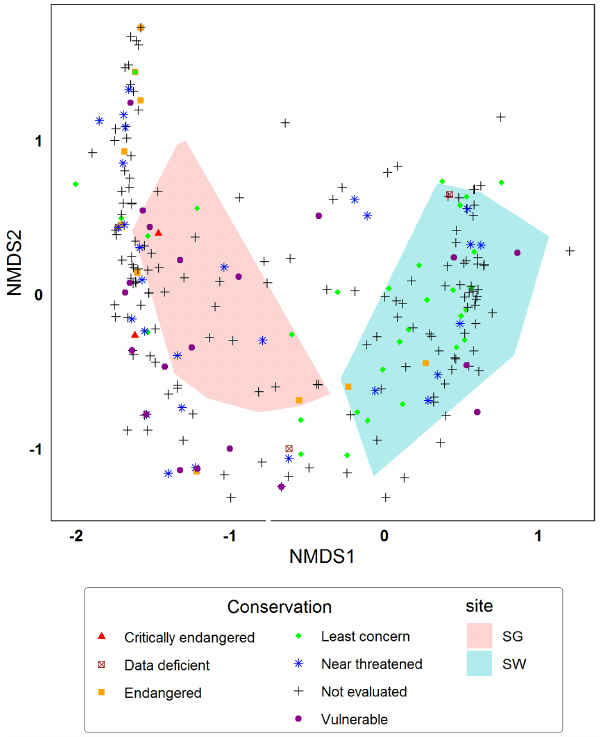
Fig. 3 . Nonmetric multidimensional scaling (NMDS) convex hull of relevés between sacred groves (SG) and surrounding silvopastoral woodlands (SW). Only species scores are depicted and to prevent overcrowding of the diagram, species names are not displayed.